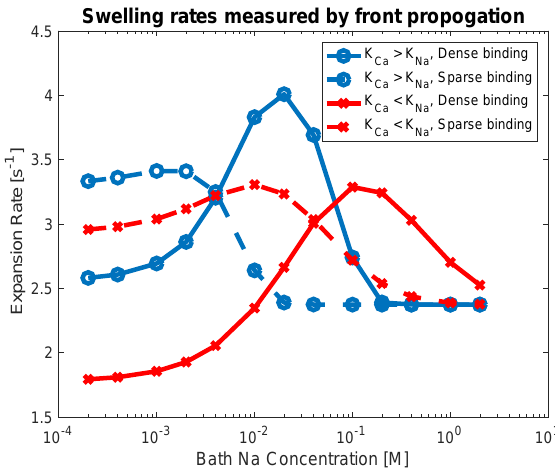
Figure 5. Computed swelling rate γ as the bath concentration of sodium is varied. Data are shown for sparse (dashed) and dense (solid) network binding in the cases where sodium (blue circles) and calcium (red crosses) binding is